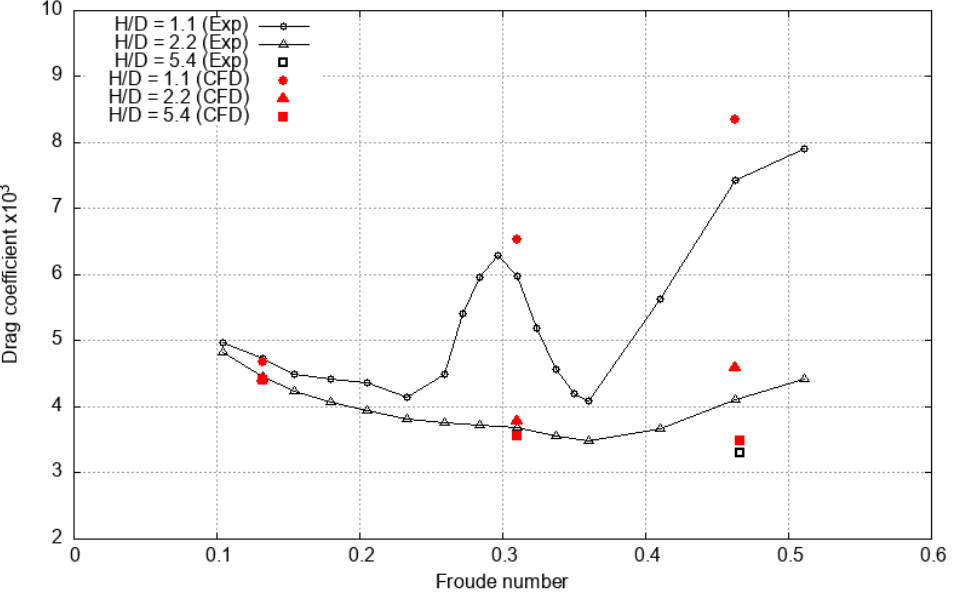
Figure 10. Total Drag coefficient variation with Froude number and immersion depth ratio for the DARPA SUB-OFF